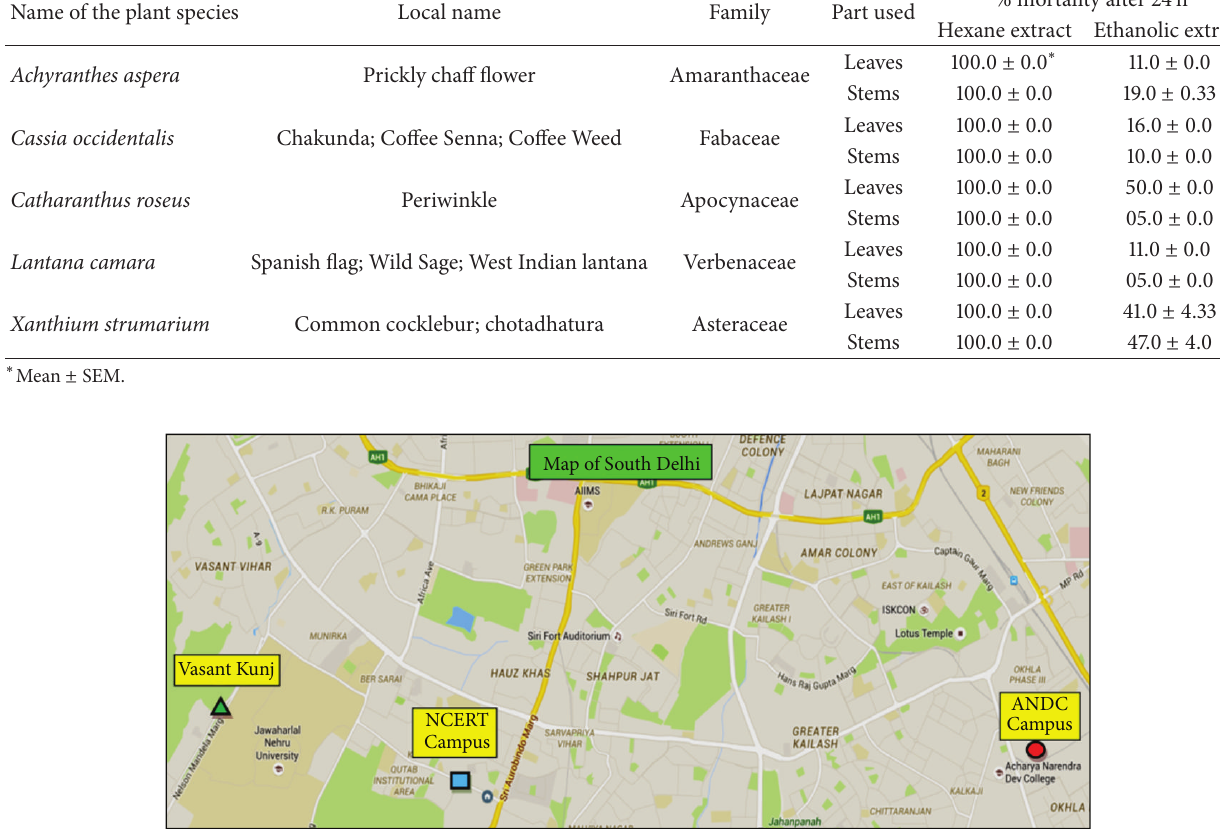
Figure 1: Different sites of the collection of different plant species in South Delhi, India. e ANDC Campus [Latitude, Longitude (28.538548, 77.262919) 28 ∘ 32 󸀠 18.7728 󸀠󸀠 N and 77 ∘ 15 󸀠 46.5084 󸀠󸀠 E] ( Catharanthus roseus ). ◼ NCERT Campus [Latitude, Longitude (28.538037, 77.192734) 28 ∘ 32 󸀠 16.9332 󸀠󸀠 N and 77 ∘ 11 󸀠 33.8424 󸀠󸀠 E] ( Lantana camara ). 󳵳 Vasant Kunj [Latitude, Longitude (28.547015, 77.161265) 28 ∘ 32 󸀠 49.2540 󸀠󸀠 N and 77 ∘ 9 󸀠 40.5540 󸀠󸀠 E] ( Achyranthes aspera, Cassia occidentalis , and Xanthium strumarium